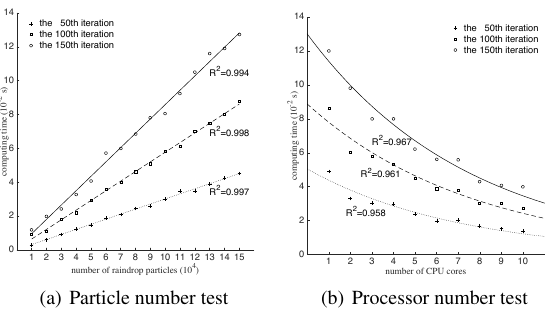
Figure 4: The test results for processor and particle